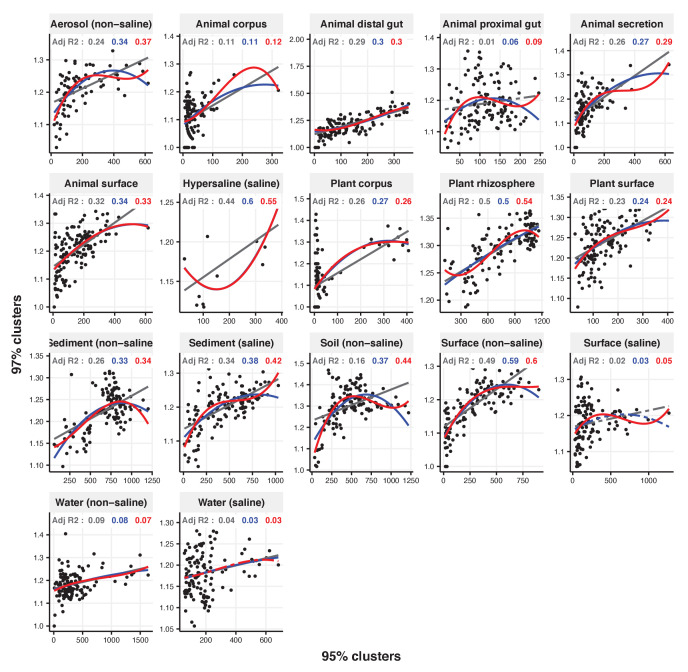
Focal clusters at 95% nucleotide identity.Community diversity was estimated as the number of clusters at a focal level (di) and focal lineage diversity as the mean of the clusters at the rank above (di 1/di). Linear (grey), quadratic (blue) and cubic (red), with corresponding adjusted R-squared values in the same colour. P-values are Bonferroni corrected for 17 tests. Significant, p<0.05 (solid lines), non-significant (dashed lines). The x-axis shows the number of clusters at the focal percent-identity level (di), and the y-axis is the mean of the clusters at the rank above (di 1/di).